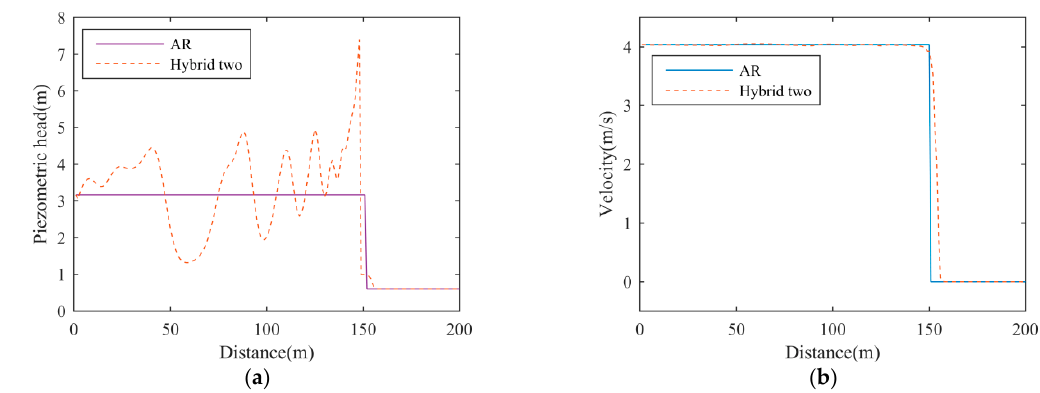
Figure 5. Comparison of the results simulated by hybrid two and the analytical result (AR): ( a ) piezometric head; ( b ) flow velocity.